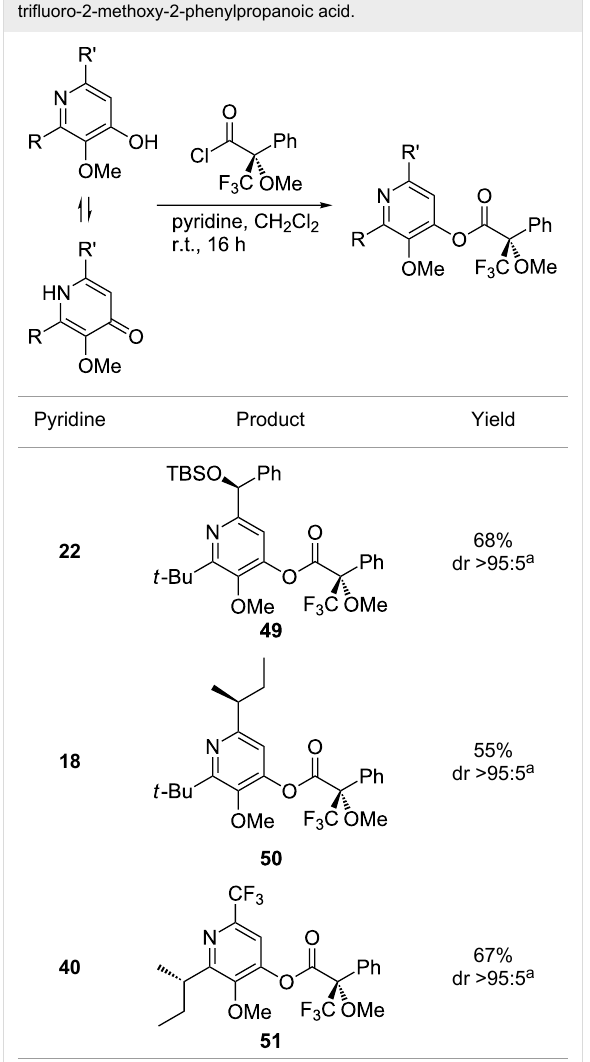
Table 2: Esterification of different pyridinol derivatives with the 3,3,3- trifluoro-2-methoxy-2-phenylpropanoic